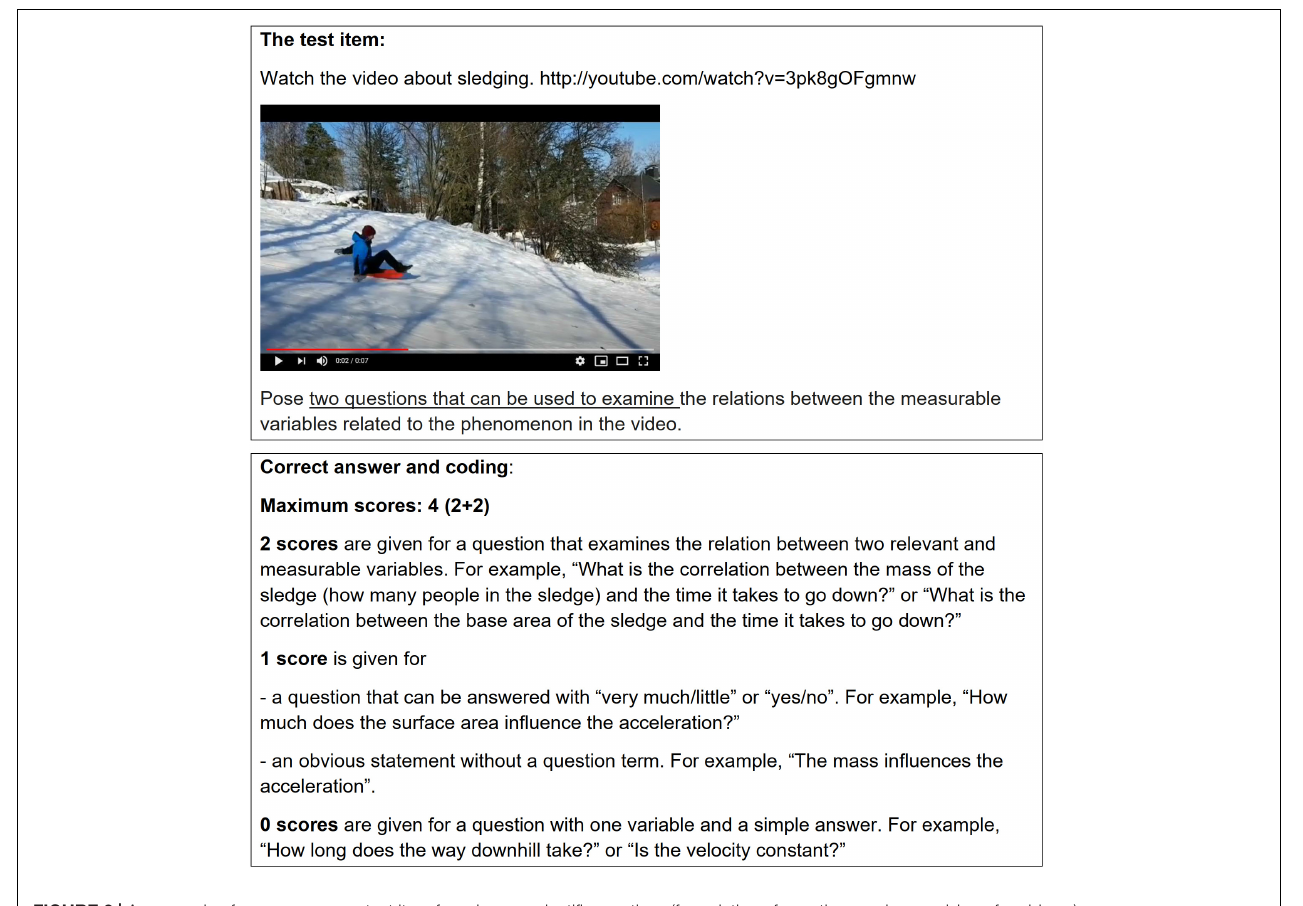
FIGURE 3 | An example of an open answer test item focusing on scientific practices (formulation of questions and recognizing of